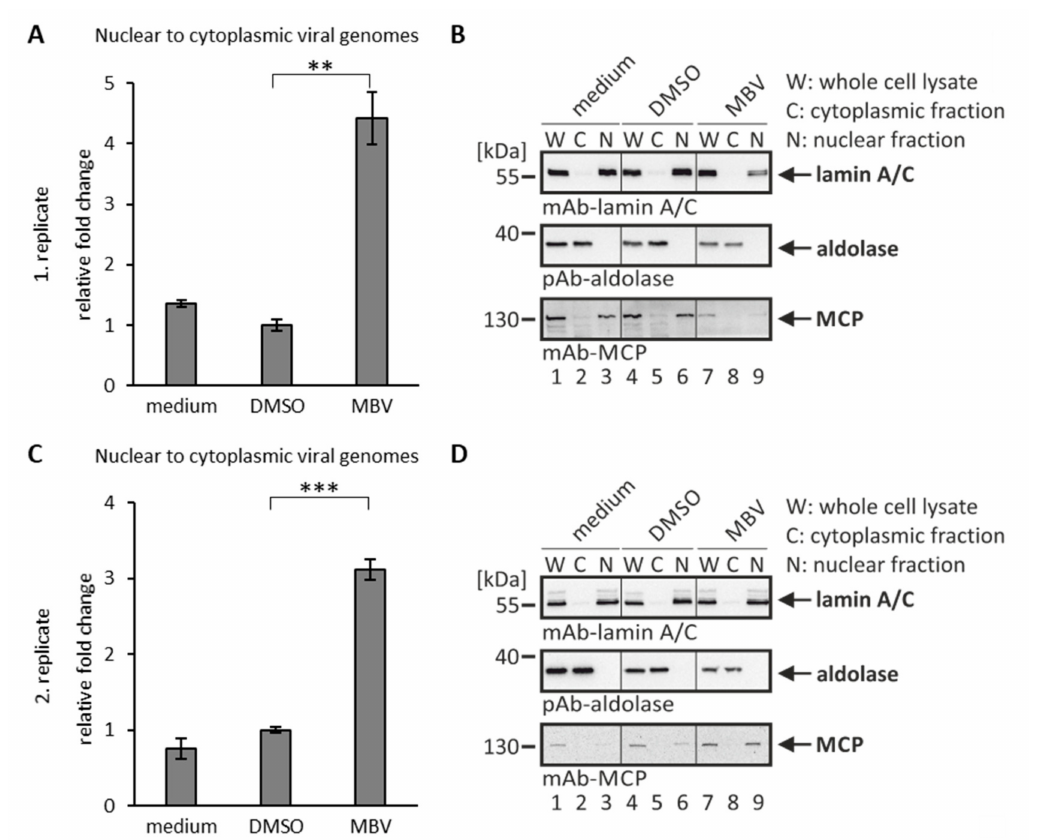
Figure 4. Nuclear egress assay based on cell fractionation and virus-specific qPCR: inhibition of nuclear egress by the viral kinase inhibitor maribavir. HFF cells were infected with HCMV AD169 at an MOI of 0.01 and treated with 5 µ M MBV or DMSO as a solvent control. At 6 d p.i., cells were harvested and the nuclear egress assay was performed. ( A , C ) The qPCR measurements were performed in technical triplicates, so that viral genome copies of C and N fractions of the two depicted biological replicates were summed up and set to 100%. The fold change between the percentages of nuclear to cytoplasmic viral genomes was calculated. Mean values ± SD are given and the significance between DMSO and MBV was calculated by Student’s t -test (** p < 0.01; *** p < 0.001). ( B , D ) Samples taken after fractionation were subjected to Wb analysis using the indicated